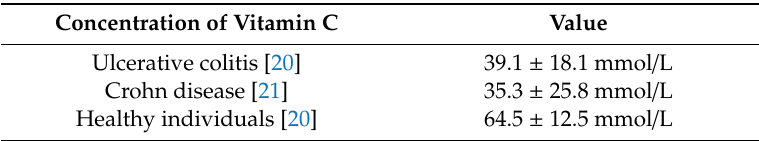
Table 1. Concentration of vitamin C among inflammatory bowel disease (IBD) patients and healthy individuals.